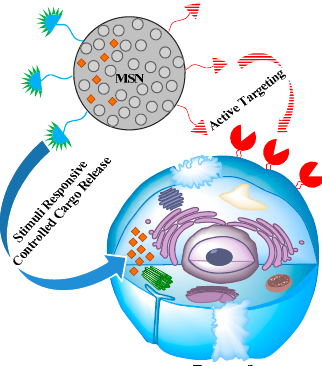
Figure 3. Multimodal decoration of MSN to achieve active targeting and stimuli responsive controlled release simultaneously.